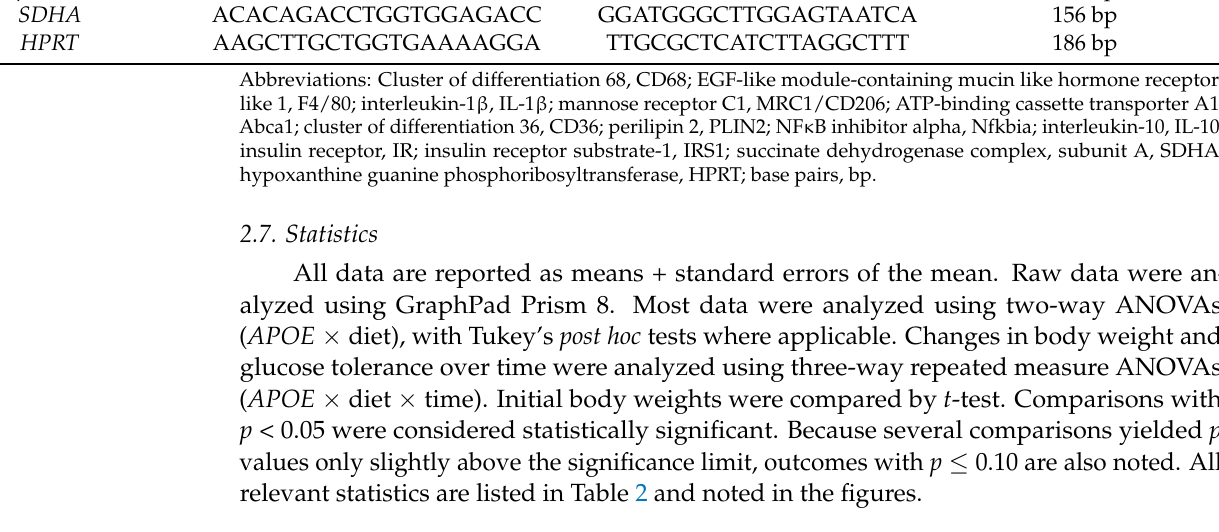
Table 2. Statistical analyses with significant or nearly significant outcomes. Figure Main Effects and